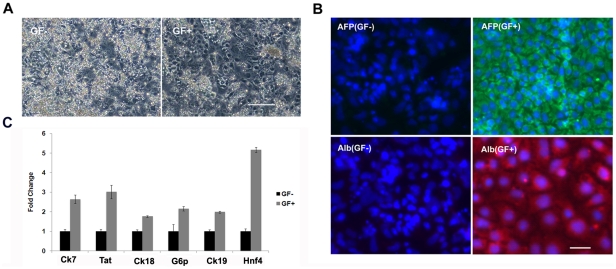
Hepatic differentiation of Activin A and Wnt3a induced mouse DE.Mouse DE cells induced by Activin A and Wnt3a were treated with growth factors (GFs) for further differentiation into hepatocytes for 8 days. A. Morphology of differentiated cells with or without GFs. Please note that the GF treated cells demonstrated typical hepatocyte like morphology. Scale bar: 50 uM. B. IF staining of AFP and Albumin (Alb) in differentiated cells. Scale bar: 20 uM. C. RT-qPCR examination of hepatocyte marker expression in the differentiated cells. Data are expressed as mean fold change ± SD. GF: 30 ng/ml FGF4, 20 ng/ml BMP2, 30 ng/ml HGF.